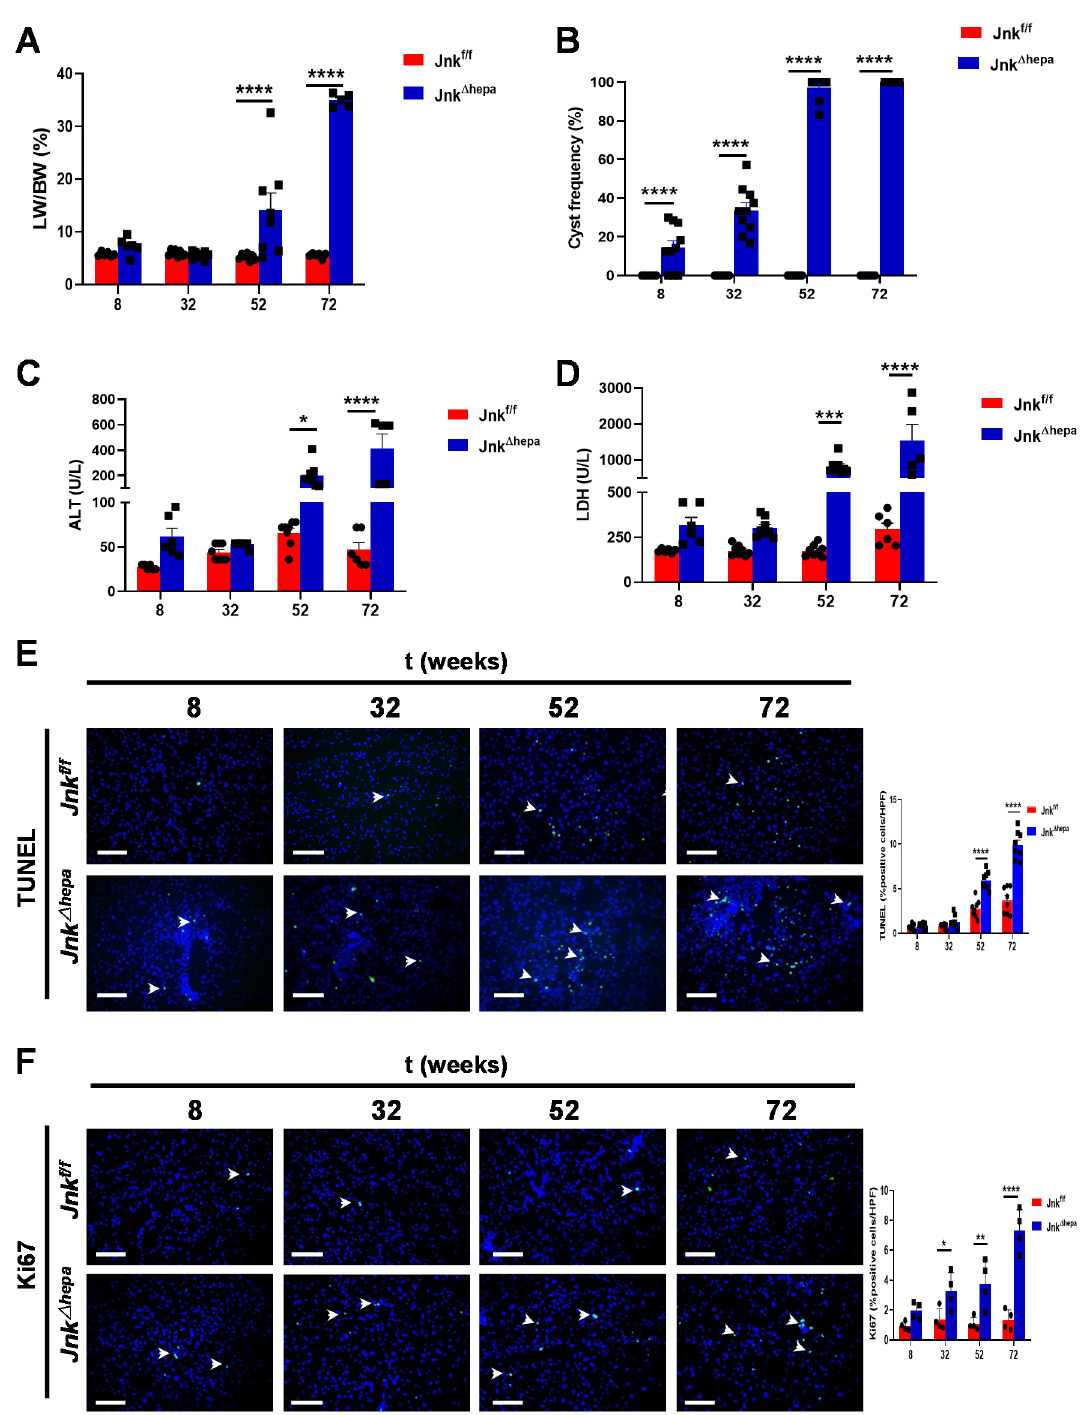
Figure 2. Hepatic deletion of Jnk1/2 promotes hepatomegaly and liver damage. Eight- to 72-week-old male Jnk f/f and Jnk Δ hepa mice were analyzed. ( A ) Representation of the LW/BW ratio. ( B ) Liver cysts were counted in the H&E liver tissue staining and represented. Serum ALT ( C ) and LDH ( D ) levels were analyzed. ( E ) Representative microphotographs of TUNEL stainings from Jnk f/f and Jnk Δ hepa mice liver tissues collected from 8 to 72 weeks of age and quantification of TUNEL-positive cells/HPF. Scale bars, 50 µm. ( F ) Representative microphotographs of Ki67 IF and quantification of Ki67-positive cells/HPF from the same mice. Scale bars, 50 µm. Data are shown as the mean ± SEM and graphed, separately ( n = 6–8 mice per group) (* p < 0.05; ** p < 0.01; *** p < 0.001; **** p < 0.0001).